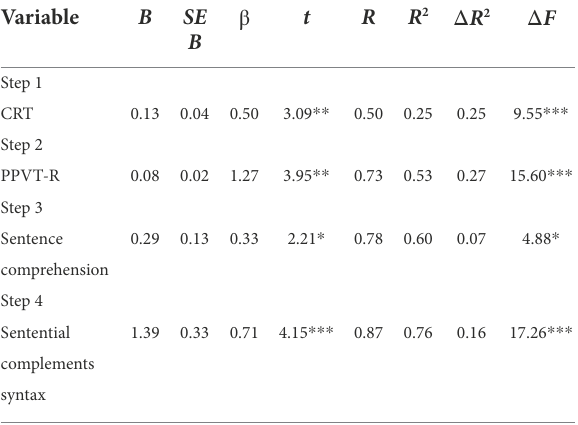
TABLE 5 Regression analysis results of verbal FB for the TD children.